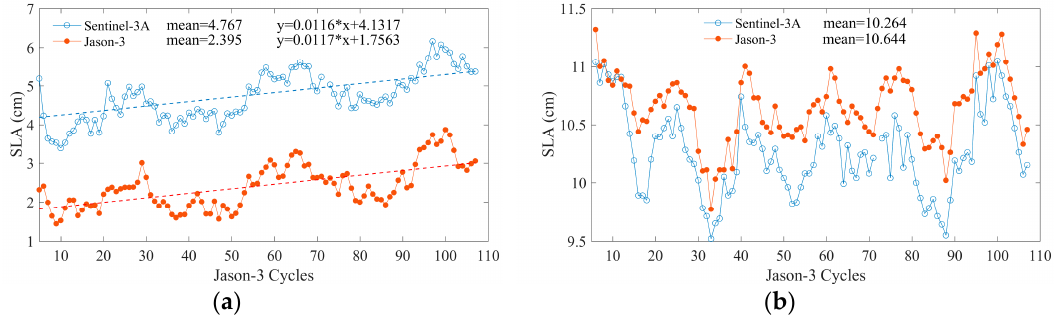
Figure 29. Comparison of cycle by cycle ( a ) means and ( b ) standard deviations of SLAs between Sentinel-3A and Jason-3 with Jason-3 repeat cycles.